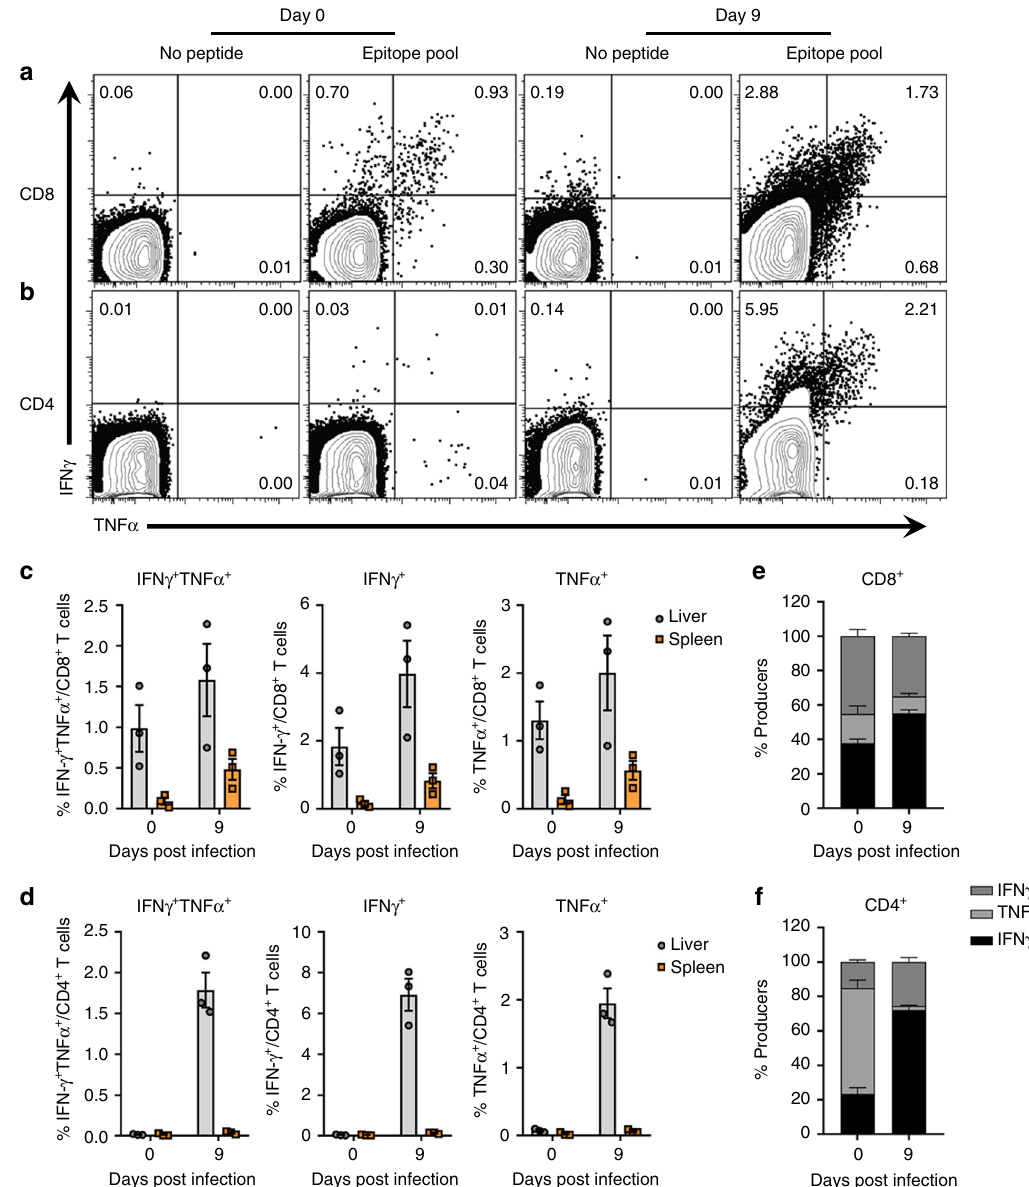
Fig. 4 RHV-speci fi c T cell responses during vaccine-mediated resolution. Lewis rats were immunized intramuscularly with 5 ×10 8 ifu Ad-NSmut. After 3 weeks, rats were challenged intravenously with 10 6 genomes RHV. At days 0 and 9 post infection, virus-speci fi c T cell responses were quanti fi ed by fl ow cytometric analysis. a , b Representative fl ow plots of intrahepatic IFN γ and TNF α production in CD8 + a and CD4 + b T cells. Mononuclear cells were stimulated for 5-h with media alone or a pool of MHC class I and II epitopes (5 µ g/mL). Numbers indicate frequency of cytokine positive cells within T cell gate. c , d Calculated frequencies of total and dual positive cytokine producers in CD8 + c and CD4 + d T cell compartments. Responses in liver (gray circles) and spleen (orange squares) are shown for comparison. Data from n = 3 rats per group are shown (mean±SEM). e , f Relative frequency of